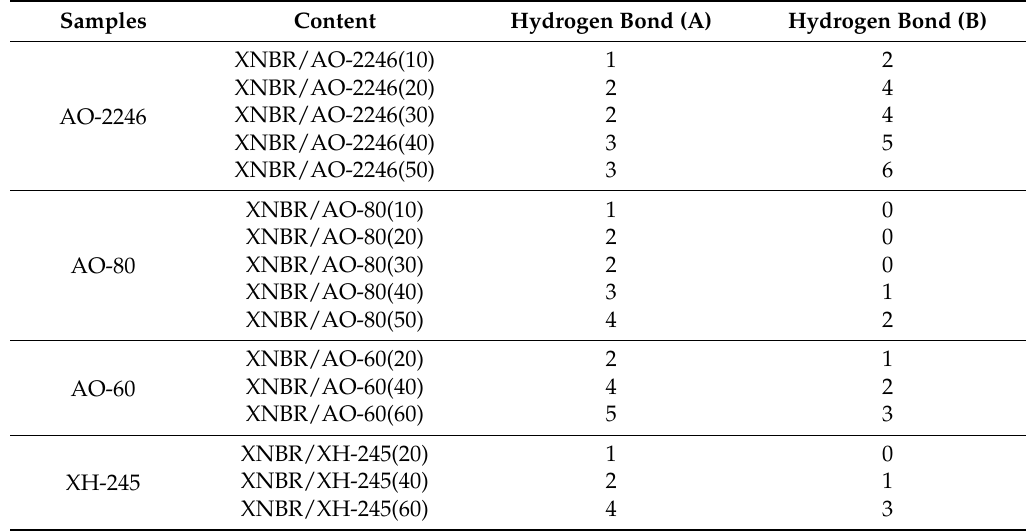
Table 2. Number of hydrogen bonds (A) and hydrogen bonds (B) in different XNBR/ hybrid phenol composites.